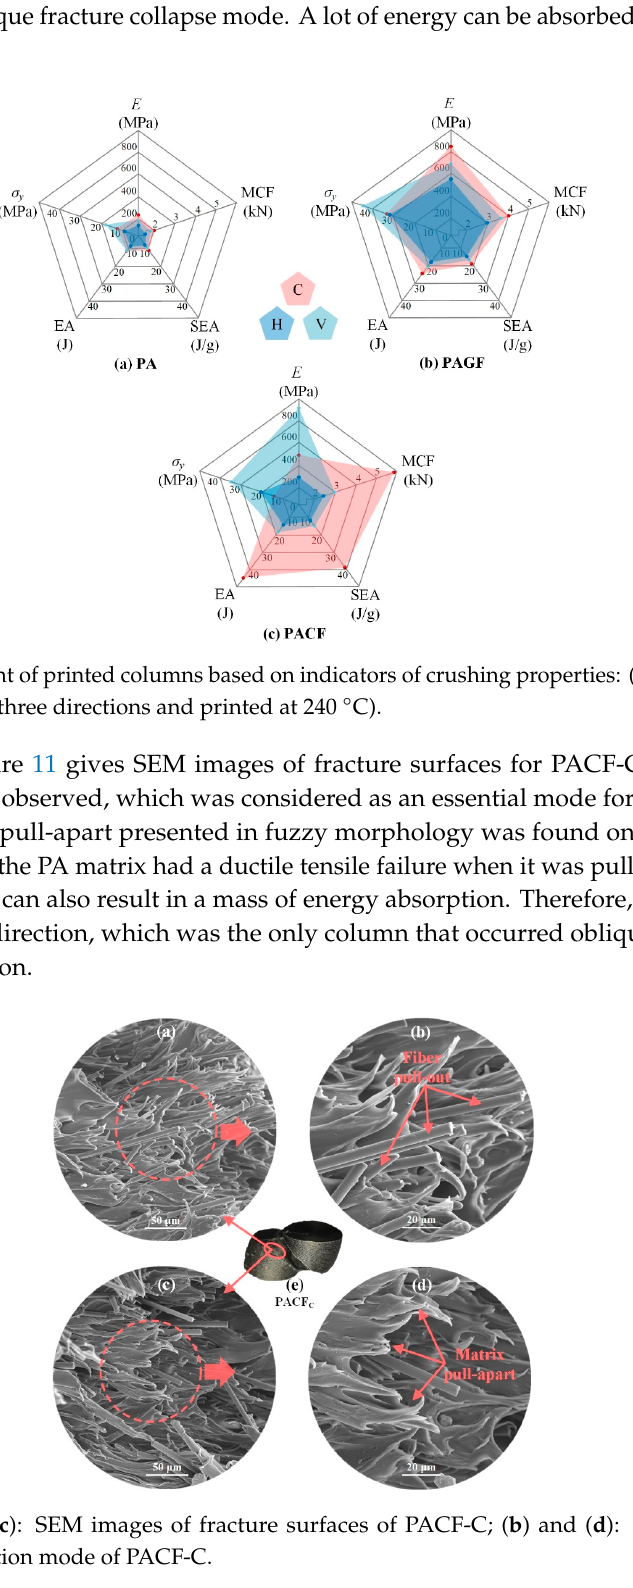
Figure 11. ( a ) and ( c ): SEM images of fracture surfaces of PACF-C; ( b ) and ( d ): enlarged views; ( e ) the final deformation mode of PACF-C. ( e ) the final deformation mode of